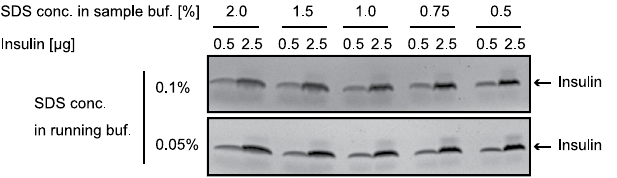
Figure 1. Optimization of SDS concentration in Tris/Tricine/urea SDS-PAGE system for insulin detection. Reference standards of insulin (0.5 or 2.5 µ g) were prepared by incubation with the SDS sample buffers containing the indicated concentration of SDS and subjected to Tris/Tricine/urea SDS-PAGE using the running buffer containing 0.1% or 0.05% SDS. The gels were stained with CBB